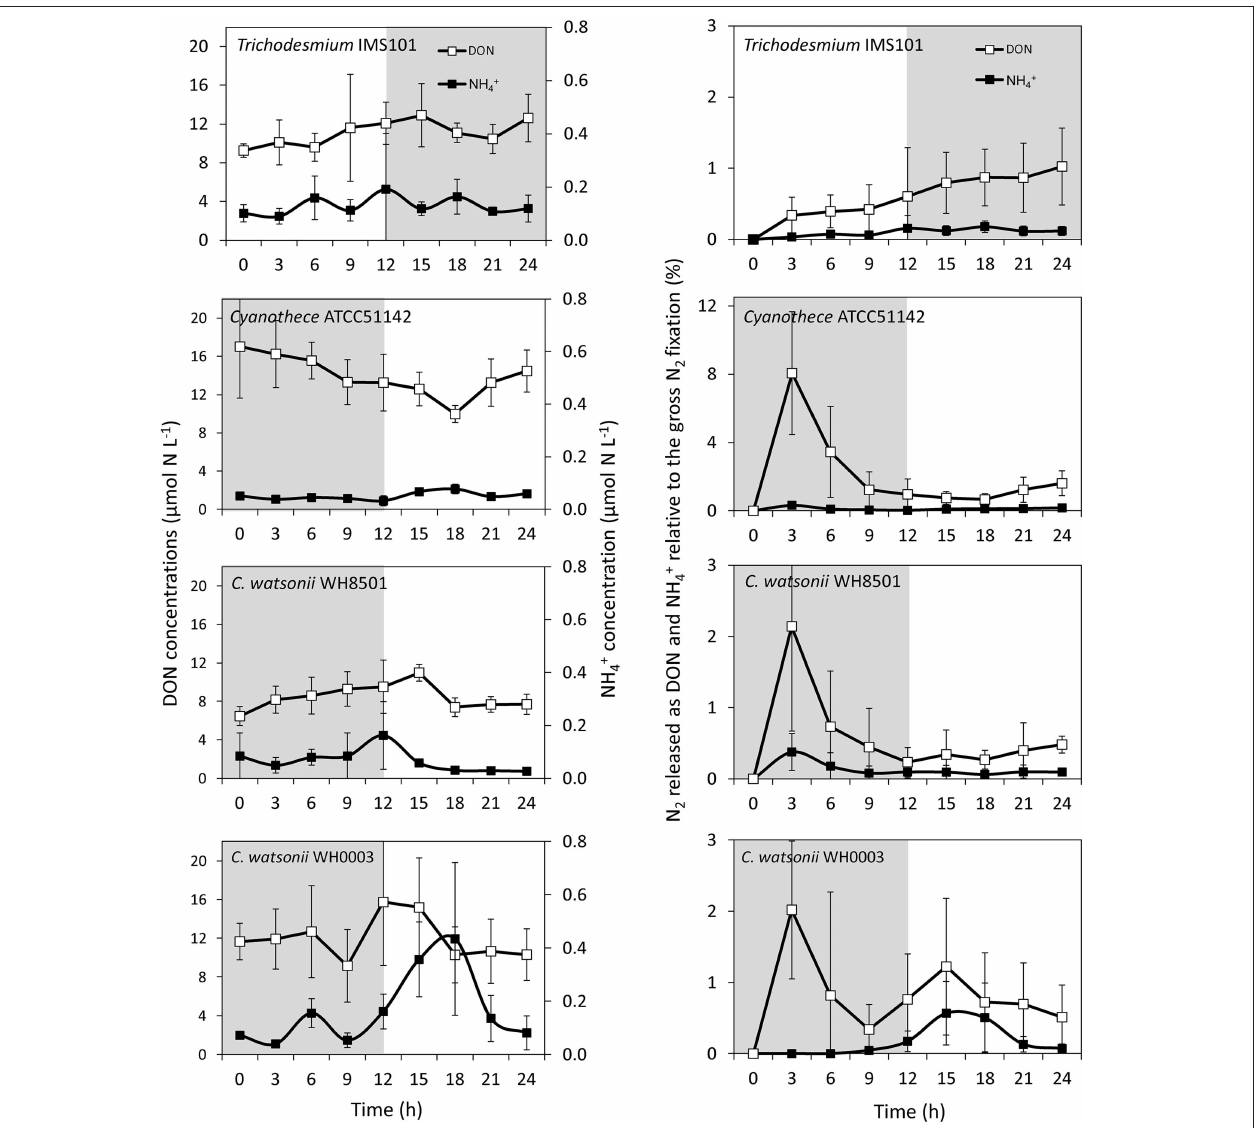
FIGURE 5 | Evolution of DON and NH + 4 concentrations along the diel cycle (left panel) and proportion of fixed N 2 released as DON and NH + 4 relative to gross N 2 fixation (right panel) as a function of the incubation time in each culture during exp 2. Error bars represent the standard deviation of triplicate measurements and the propagated analytical error. Gray areas represent the dark periods.